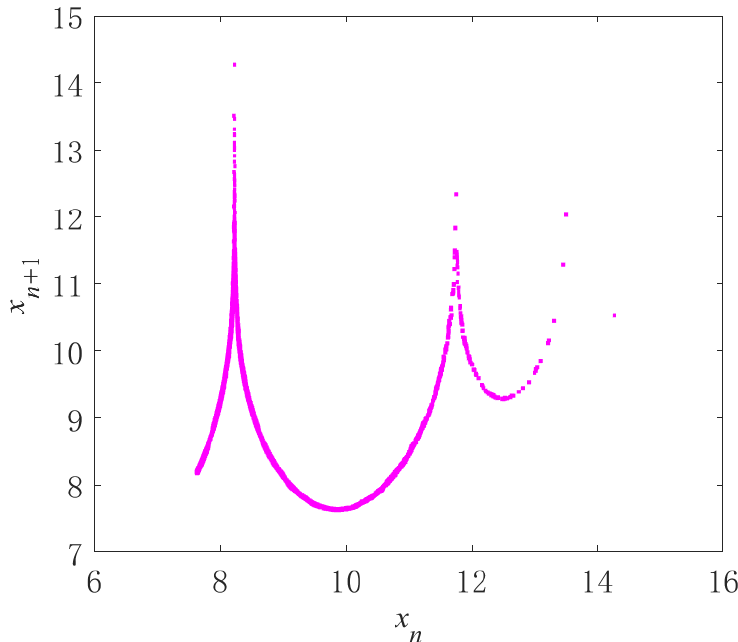
Figure 13. Poincaré first return map with a section z = − 10 for ( a , b , c , k ) = ( 12,100,10,4.6 ) . (1) For a cycle with a smooth ellipse shape around a fixed point, the symbol 0 is used to denote the cycle around the left and the symbol 1 is used to denote the cycle around the right. (2) For an irregular cycle around a fixed point with a smaller extension on the z -axis around 100, which has a blunt fold, in the shape of a raised wing, the symbol 2 is used to denote the cycle around the left and the symbol 3 is used to denote the cycle around the right. (3) For an irregular cycle around a fixed point with a larger extension on the z -axis around 140, which has a very sharp fold, forming the shape of a ginkgo leaf, the symbol 4 is used to denote the cycle around the left and the symbol 5 is used to denote the cycle around the